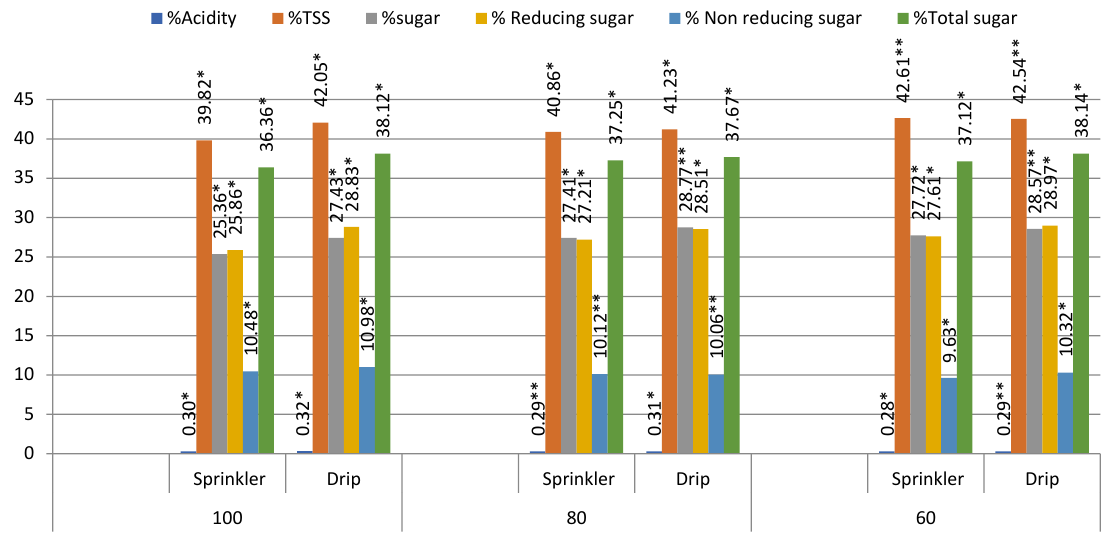
Hectare, WP: Water productivity, M 3 : Quebec meter.